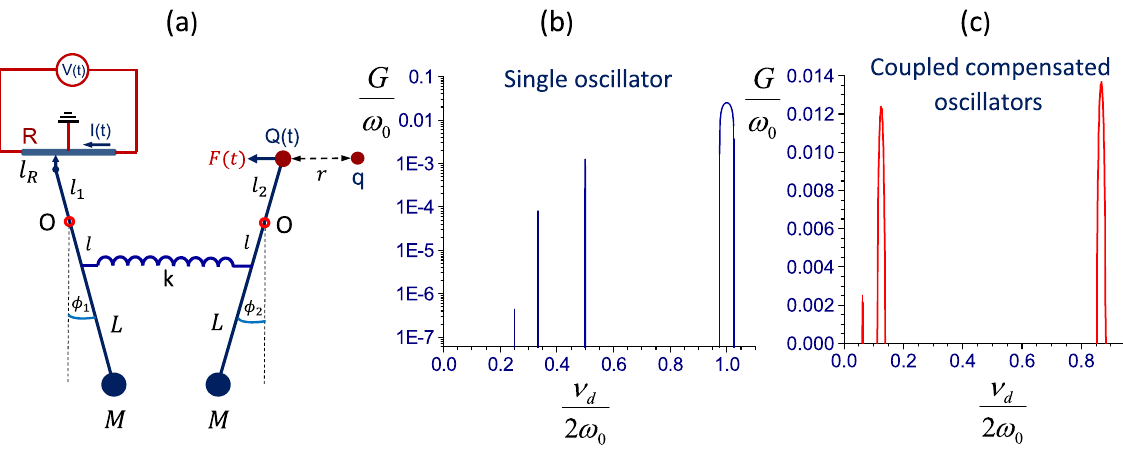
FIG. 3. (a) Electromechanical analog of the QASER. Masses M are attached to conducting rods, which are pivoted at points O . The pendulums are weakly coupled with each other by a conducting spring. Pendulum 1 corresponds to the field and pendulum 2 to the atoms. A metallic sphere is attached to the top of the second pendulum, while the upper end of the first pendulum slides without friction along the resistor R connected to the ac voltage supply V ð t Þ . The middle point of the resistor is grounded. A charge q , placed at a fixed position, interacts with the charge on the metallic sphere Q ð t Þ , which is proportional to V ð t Þ and to the displacement (cid:9) 1 of the first pendulum from equilibrium. This interaction modulates the coupling strength between the pendulums. (b) Gain for a single obtained by numerical solution of Eq. (36) with (cid:4) 2 =! 2 0 ¼ 0 : 25 and (cid:7) ¼ 0 : 4 . The oscillator as a function of modulation frequency (cid:3) d vertical axis has a logarithmic scale. (c) Gain for compensated coupled oscillators as a function of modulation frequency (cid:3) obtained d by numerical solution of Eqs. (34) and (35) with (cid:4) 2 =! 2 0 ¼ 0 : 25 and (cid:7) ¼ 0 : 4